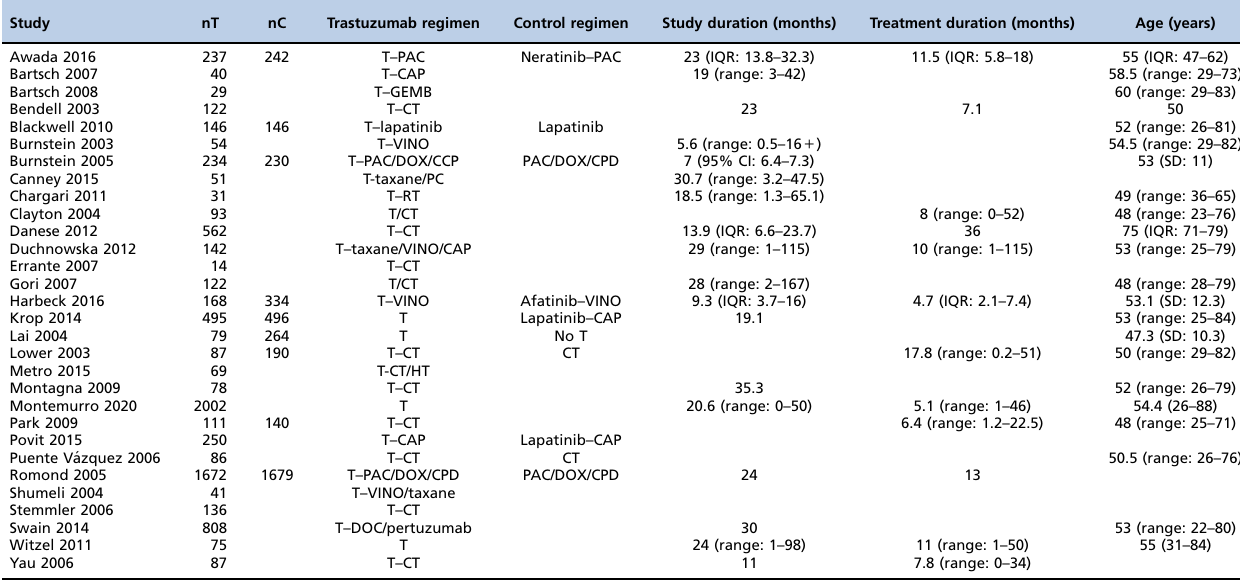
Table S1 - Important characteristics of the included